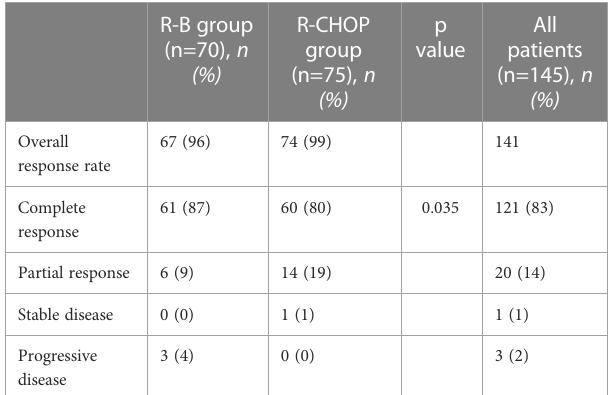
TABLE 2 Clinical